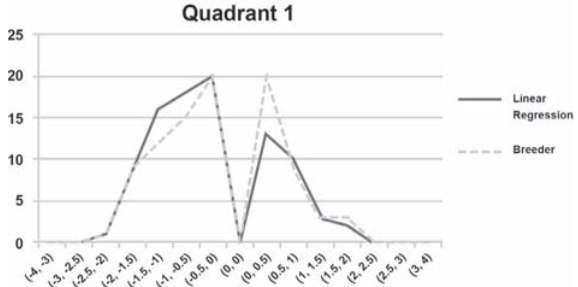
Figure 3- The comparison of prediction error in quadrant 1